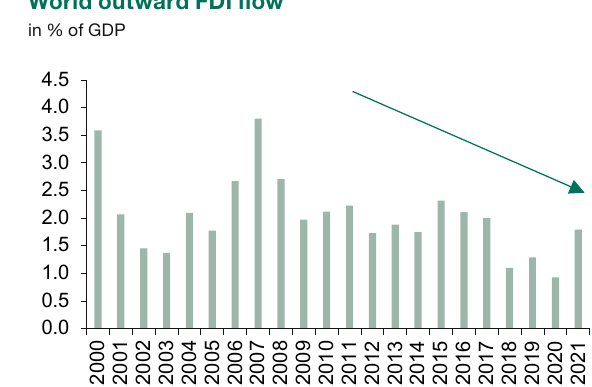
World inward FDI fl ow